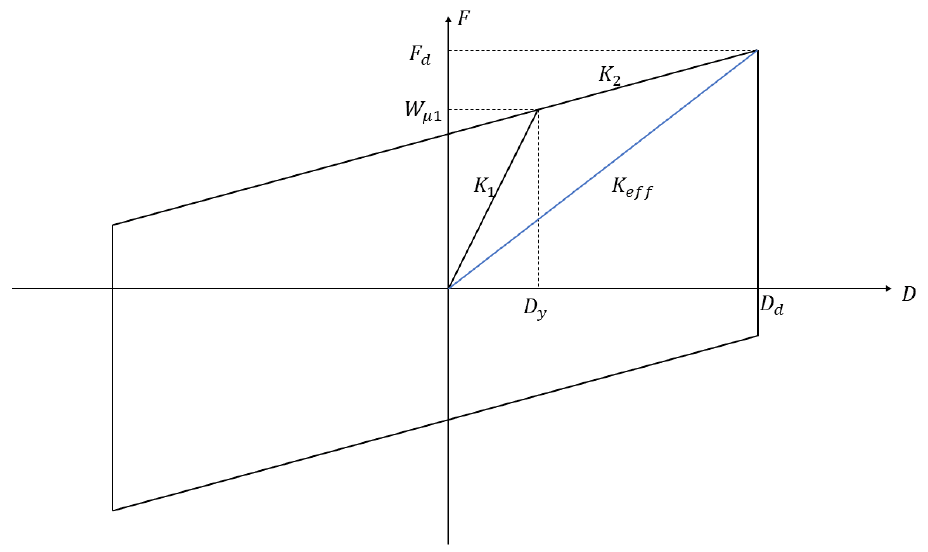
Figure 8. Bilinear calculation model of FPB.